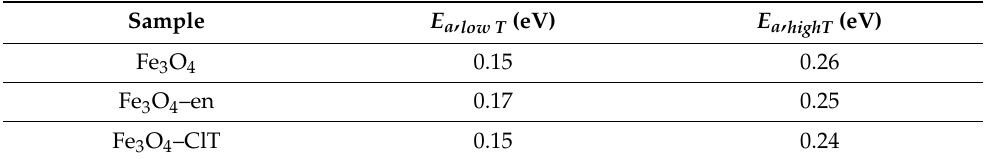
Table 4. Activation energies ( E a ) of electrical conductivity in low- (173–233 K) and high-temperature (243–363 K) ranges determined from Arrhenius